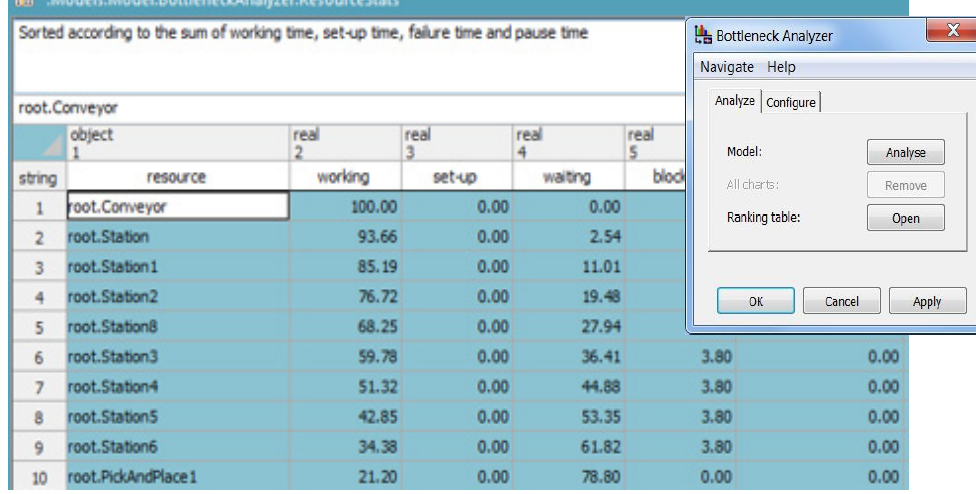
Figure 8. Bottleneck Analyzer: the percentage of workstation usage.